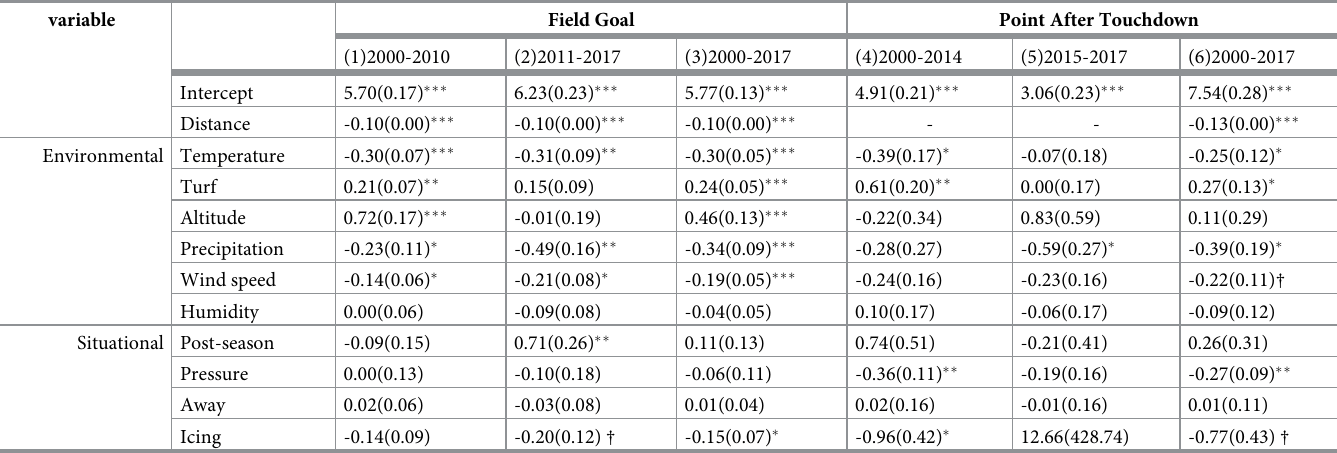
Table 2. Logistic regression on environmental and situational variables.